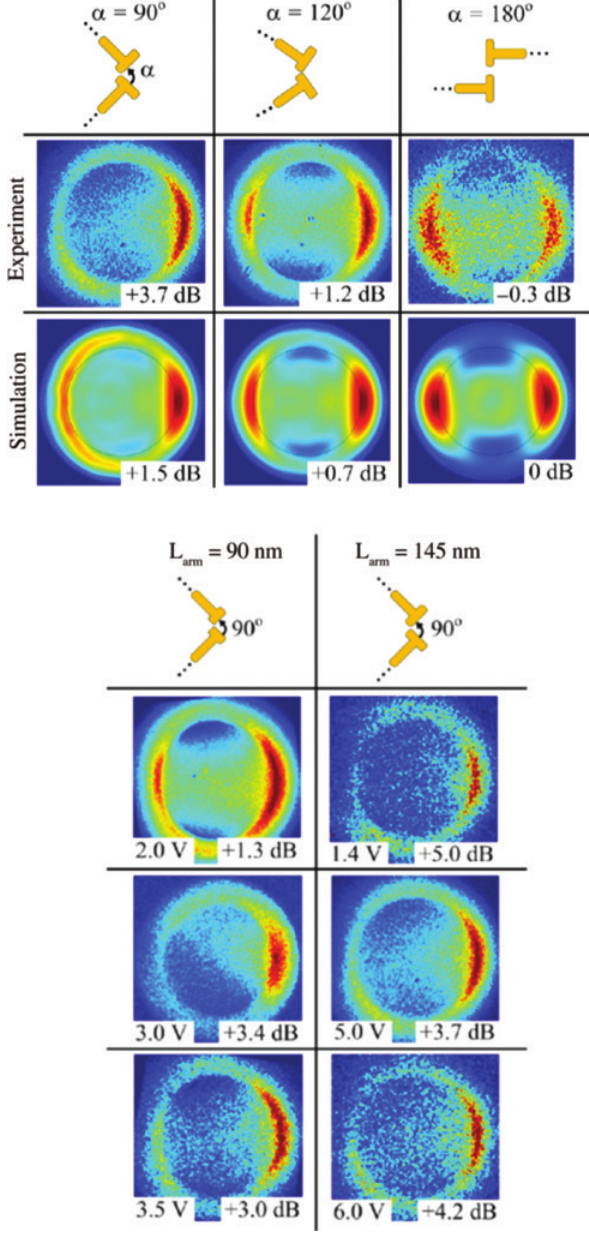
Figure 7: (Upper panel) Evolution of the directivity with the opening angle of a